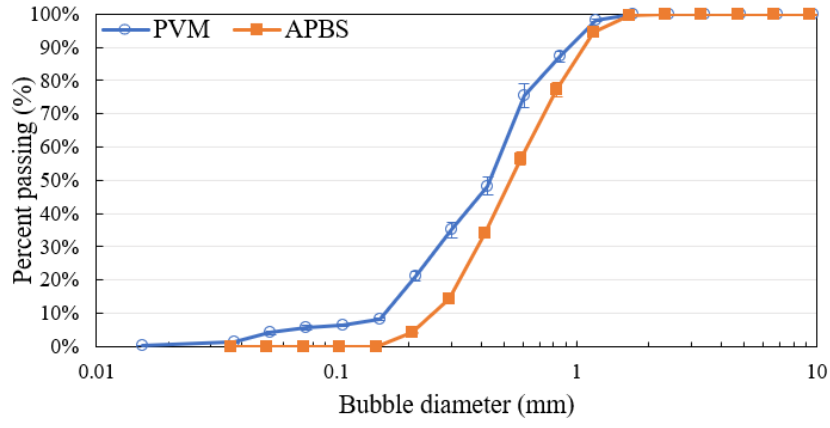
Figure 9. Bubble size distributions obtained using the PVM and APBS probes (there are error bars for APBS, but they are small and not visible).